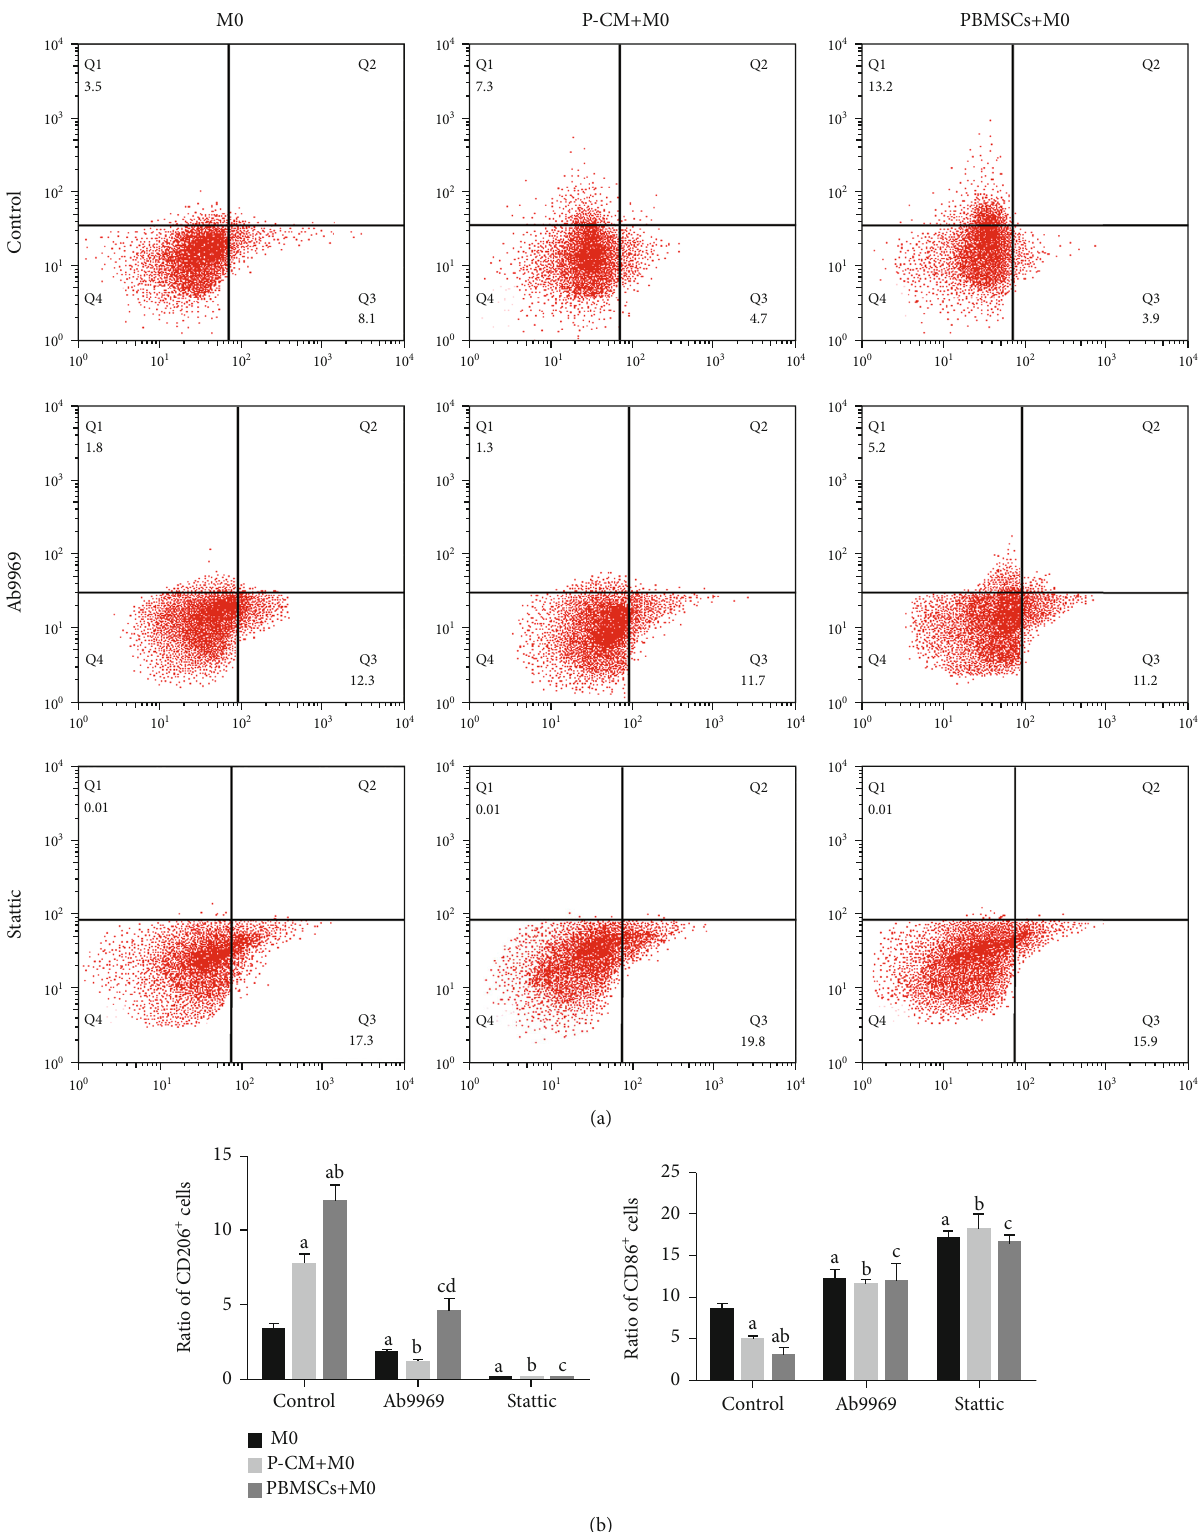
Figure 6: Phenotypes of macrophages from various groups as detected by fl ow cytometry. (a) The expression of CD206 and CD86 in macrophages under di ff erent culture conditions. (b) The ratio of CD206 + or CD86 + cells in various groups. Graphs show the mean ± standard deviation ; n = 3 ; a P < 0 : 05 comparing the M0 group vs. the control group, b P < 0 : 05 comparing the P-CM+M0 group vs. the control group, c P < 0 : 05 comparing the PBMSC+M0 group vs. the control group, and d P < 0 : 05 comparing the M0 group vs. the Ab9969 group. CD: cluster of di ff erentiation; P-CM: PBMSC-conditioned media; PBMSCs: peripheral blood-derived mesenchymal stem